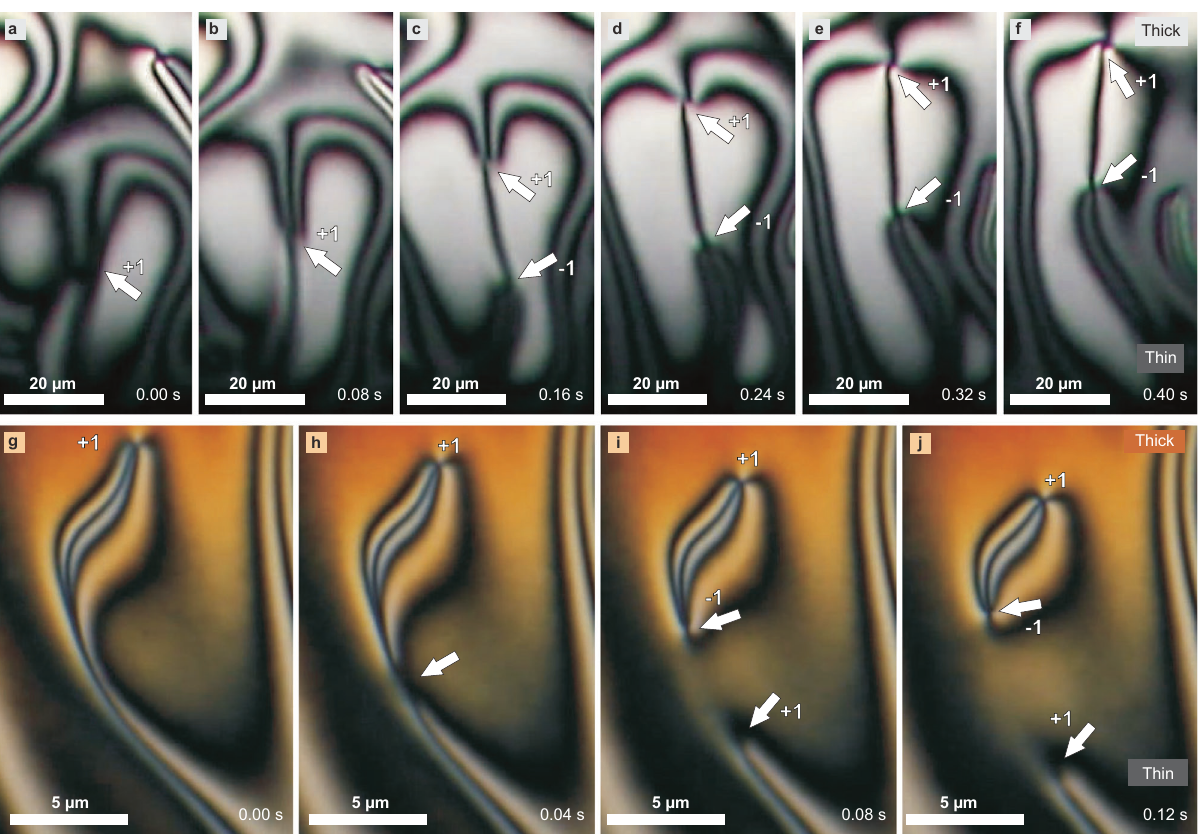
Fig. 2 | Formation of topological defects with integer winding number. a – f Series of snapshots showing the formation of a pair of oppositely charged defectswithanintegerwindingnumber.Inatypicaldefect-formationevent,anarea spontaneouslyappears(seewhitearrowin( a )).Asthisareamovestowardsthecore of the drop, it spontaneously splits into a pair of defects, which are clearly seen in panel( c ).Thetwodefectsthentravelupwardsandusuallyannihilate,asthesecond